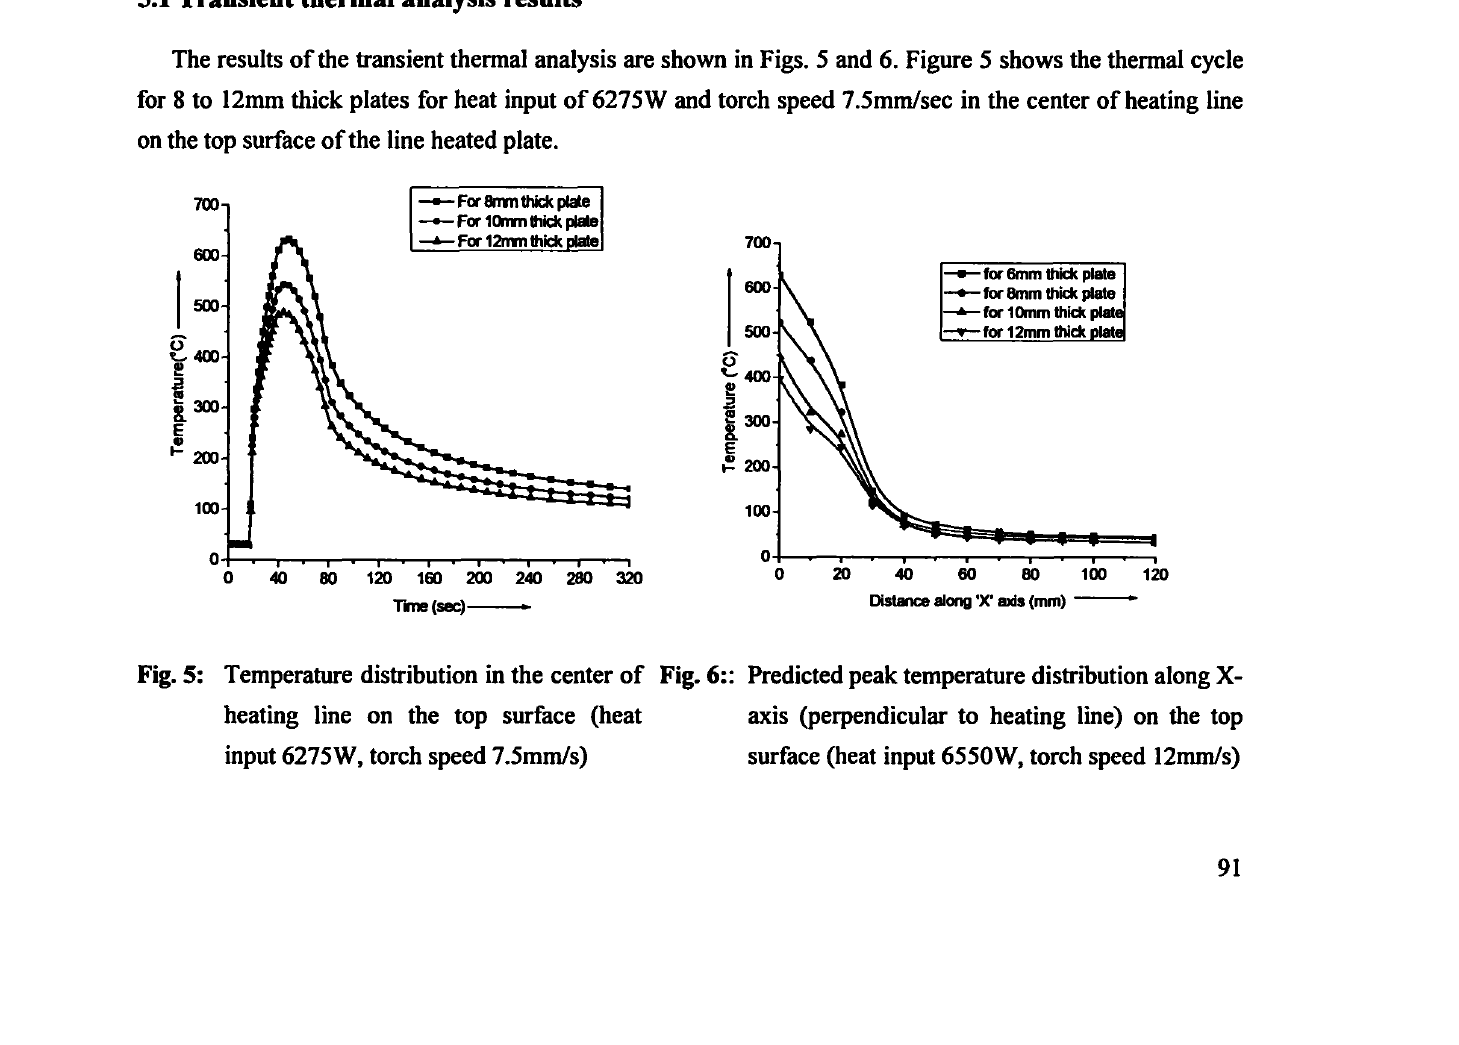
Fig. 5: Temperature distribution in the center of Fig. 6:: Predicted peak temperature distribution along X- heating line on the top surface (heat axis (perpendicular to heating line) on the top input 6275W, torch speed